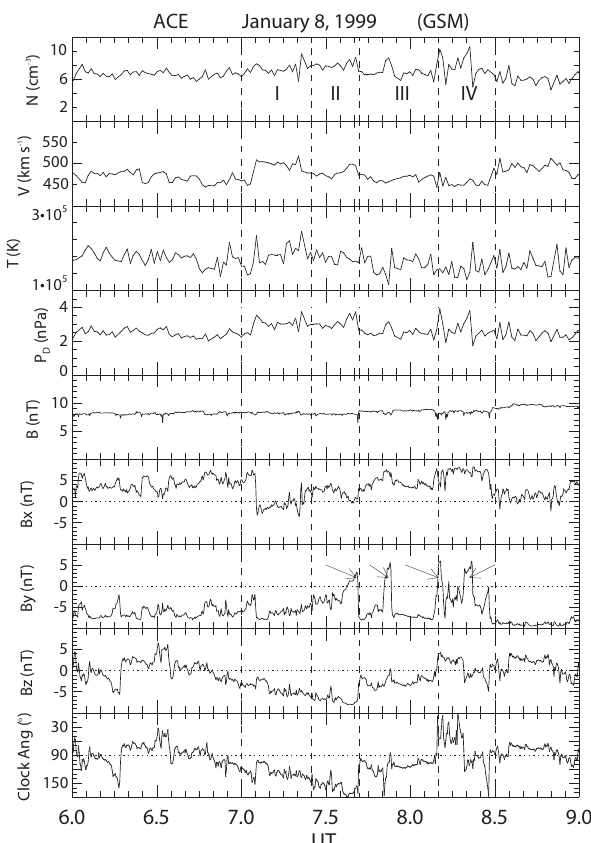
Fig. 15. ACE solar wind plasma and IMF data for the interval 06:00–09:00UT. Panels show from top to bottom proton density, bulk speed, proton temperature, dynamic pressure, the total mag- netic field and its components B x , B y , and B z . The bottom panel shows the IMF clock angle. Subintervals are delimited by verti- cal guidelines. Abrupt changes of IMF B y polarity are marked by